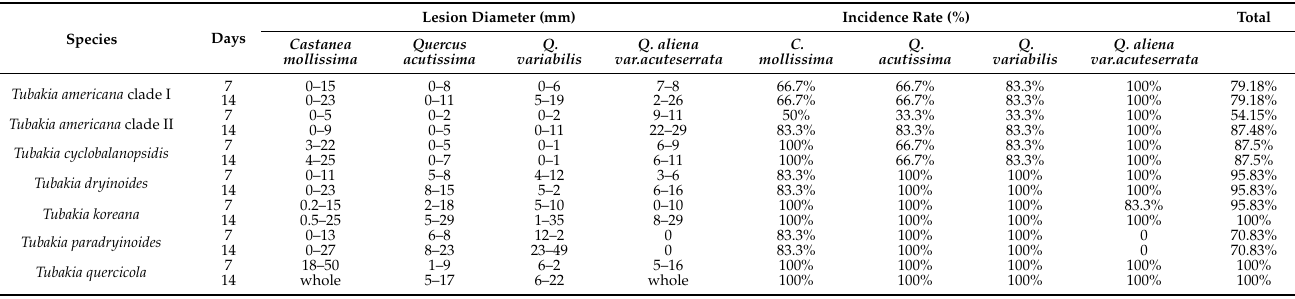
Table 4. Pathogenicity testing for six Tubakia